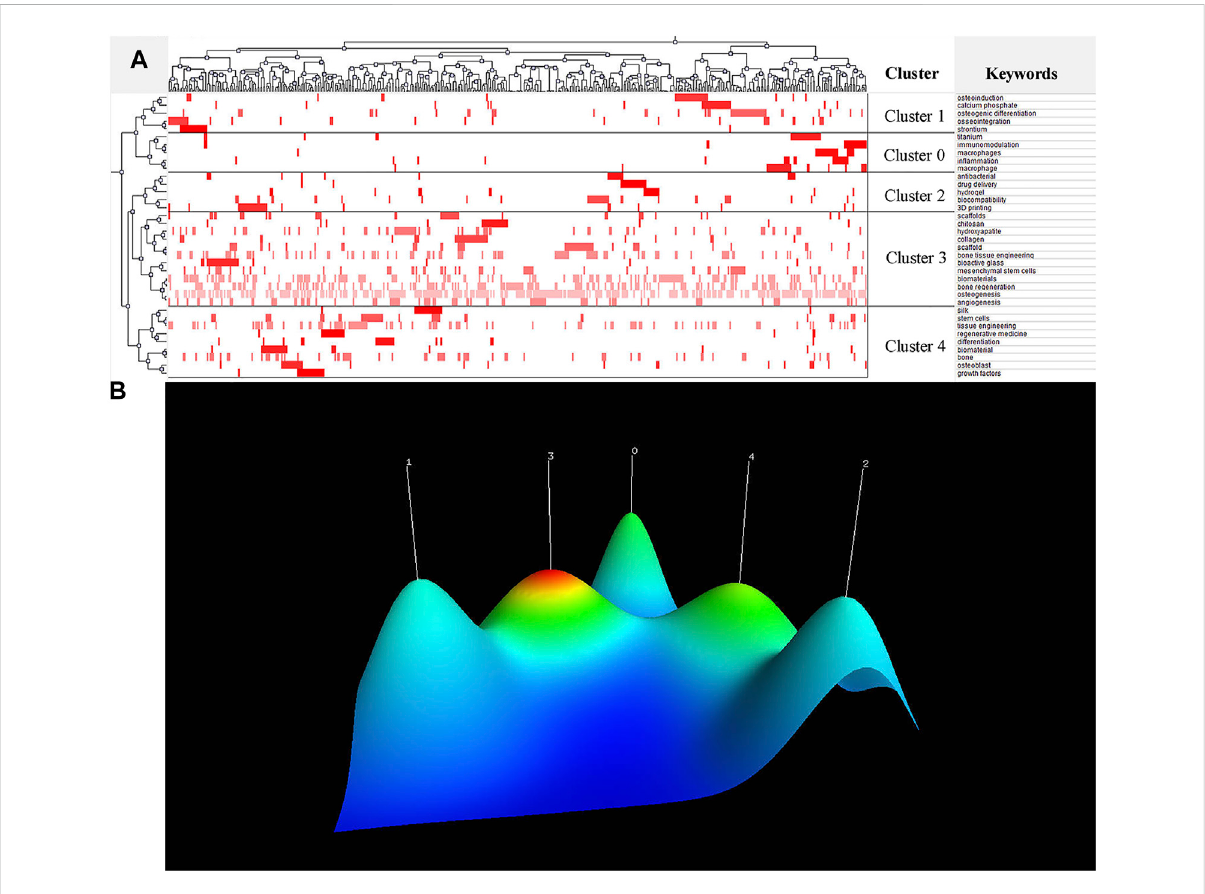
FIGURE 6 Research hotspots in the fi eld of biomaterials research in osteogenesis. (A) Visualized matrix of biclustering of highly frequent keywords in the fi eldofbiomaterialsresearchinosteogenesis.Colorofeachblotrepresentedthefrequencyofoccurrenceofkeywordsinallliteratures. (B) Mountain visualization of biclustering of highly frequent keywords in the fi eld of biomaterials research in osteogenesis. The height and color of the mountain are proportional to internal similarity and standard deviation of cluster. Blue: high deviation, Red: low